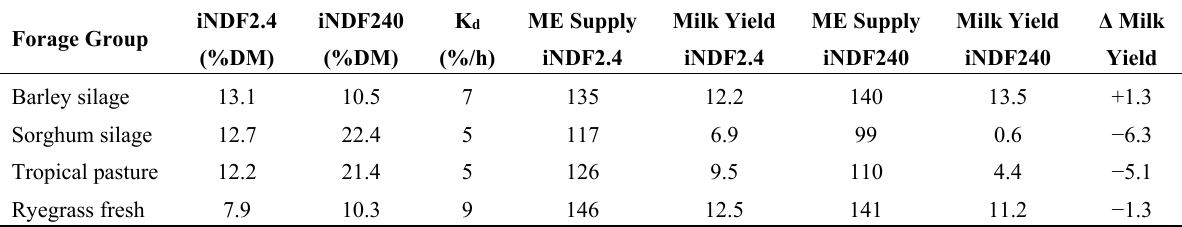
Table 1. Milk production (kg/day) and total metabolisable energy (ME) supply (MJ/day) estimates from the CNCPS, based on predicted iNDF2.4 or in vitro iNDF240 of forage groups relevant to dairy diets in Queensland,